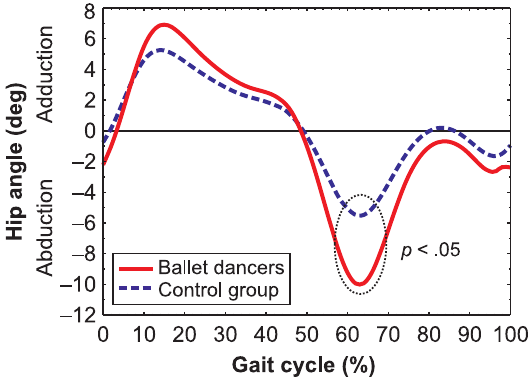
Figure 2. Knee movement in the sagittal plane during gait in dancers and the control group